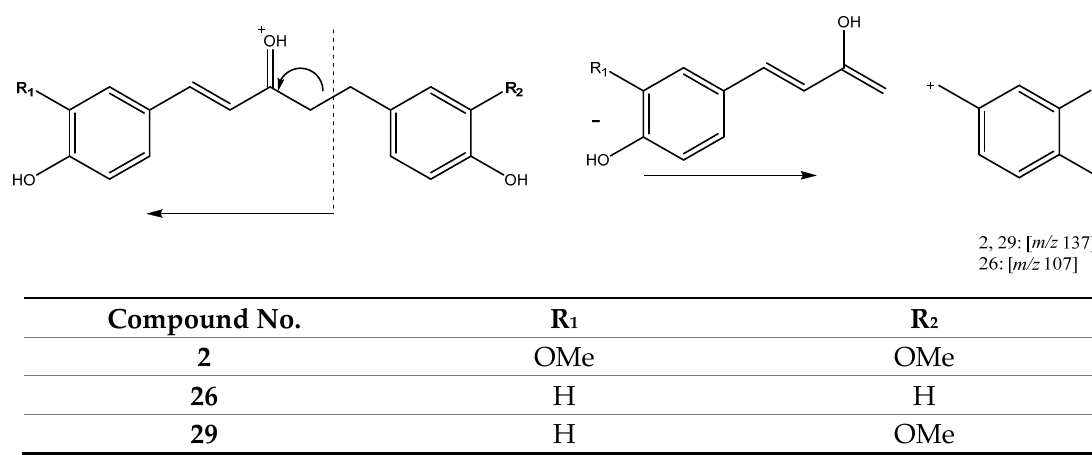
Figure 7. Fragmentation pathway for peaks 2 , 26 and 29 .